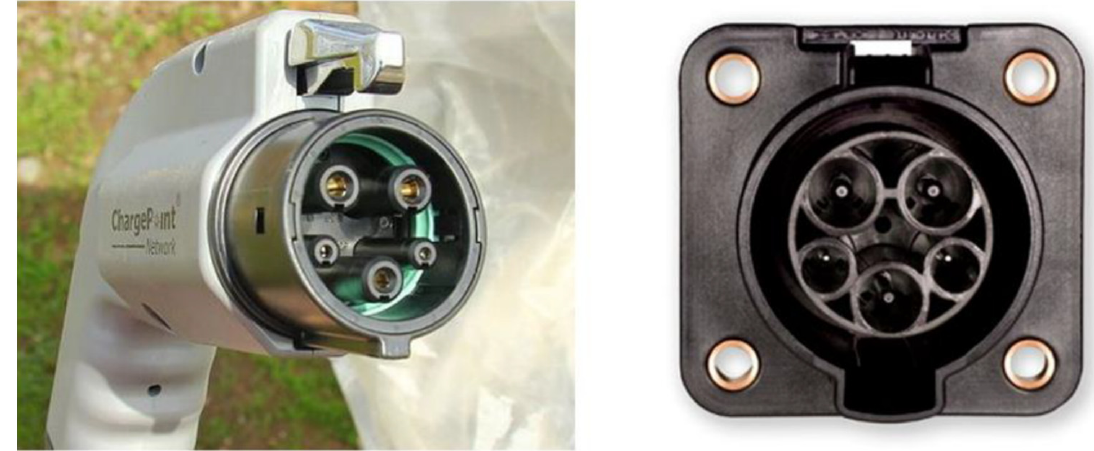
Figure 11. The SAE J1772 EV charging coupler: EV Plug ( Left ) and Inlet ( Right ).